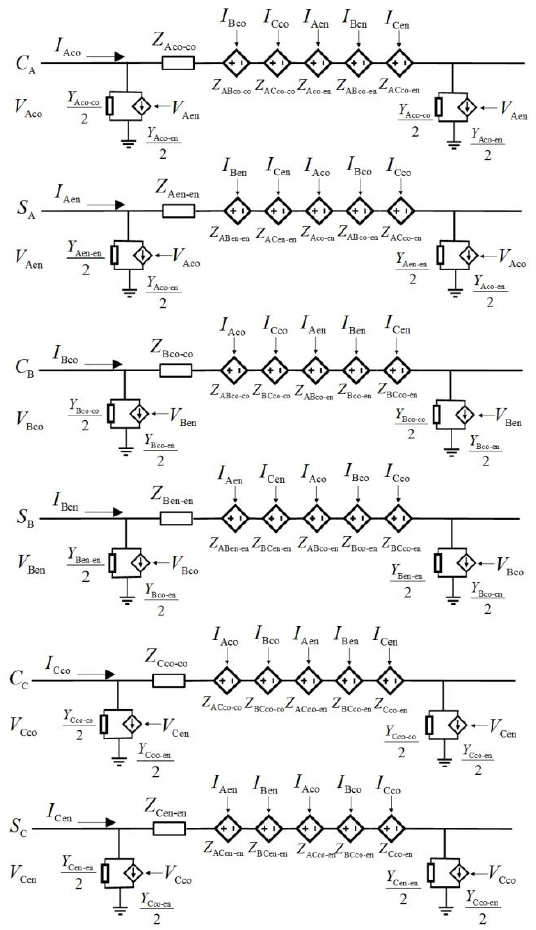
Figure 7. GIL equivalent model based on PI-model.